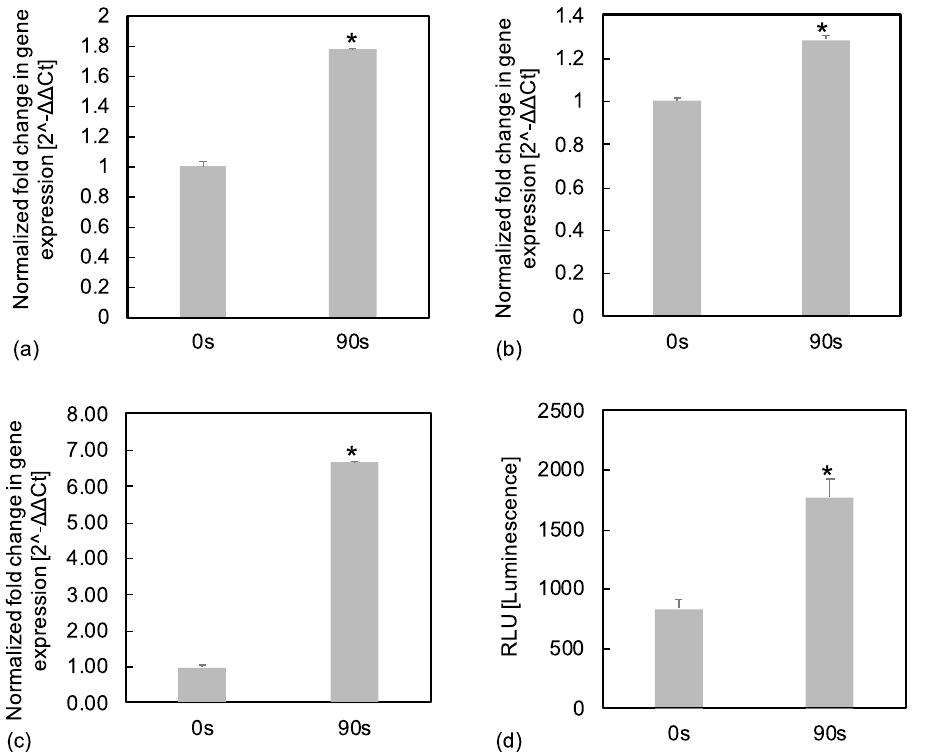
Figure 6. ( a )–( c ) Real-time PCR analysis of alterations of mRNA expressions in Jurkat cells after plasma treatment in vitro. Increased expressions of ( a ) P53 , ( b ) BID , and ( c ) BAD following plasma treatment was shown as mean of fold-changes vs untreated controls (0 s exposure). The expression of housekeeping gene GAPDH was used for normalisation. ( d ) The caspase 9 activities in plasma treated and untreated Jurkat cells were measured. The luminescent signal (RLU) generated was proportional to the amount of caspase 9 activities present. Data represent mean of independent tests (n = 3). ( a )–( d ) show significant differences in mRNA expression and caspase 9 activity between plasma treated cells vs the control ( p < 0.05